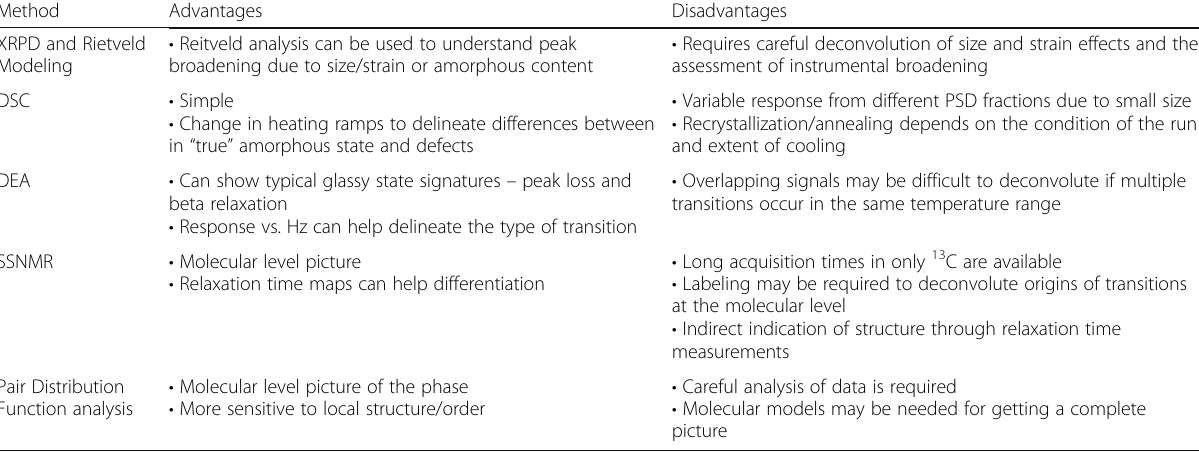
Table 2 Methods used to detect and differentiate amorphous state and defects